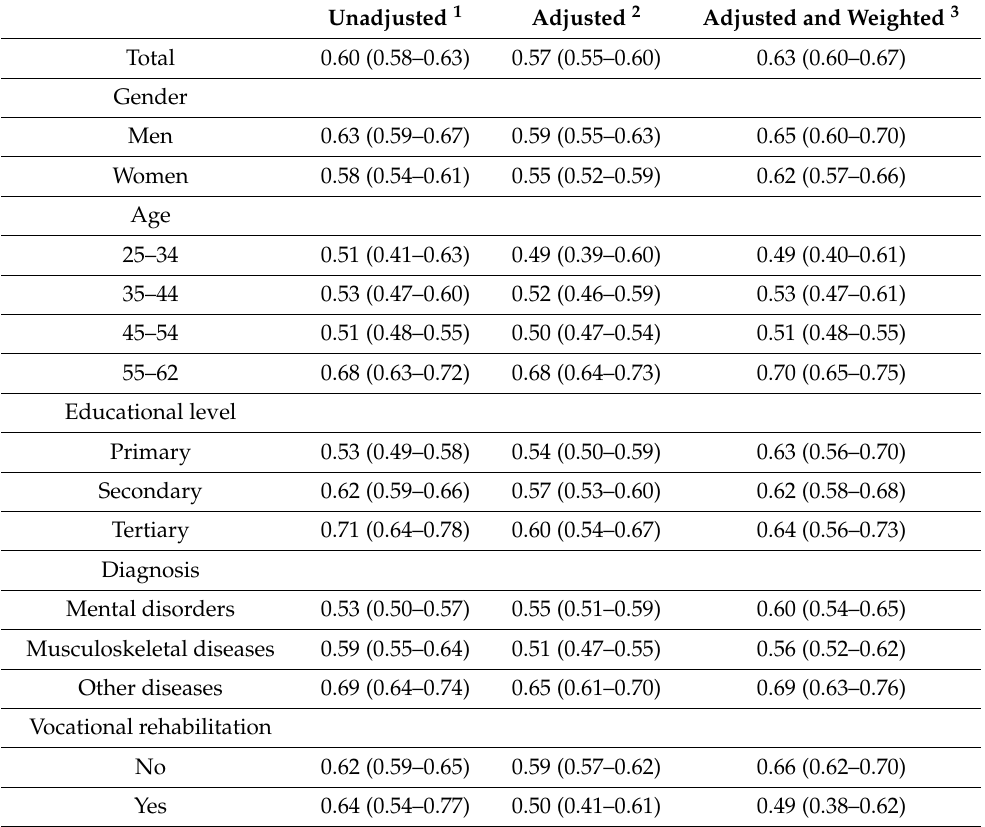
Table 3. Change in the rate of transferring to permanent disability pension by the study variables, comparing those starting their fixed-term disability pension in 2015 with those who started their fixed-term disability pension in 2006.